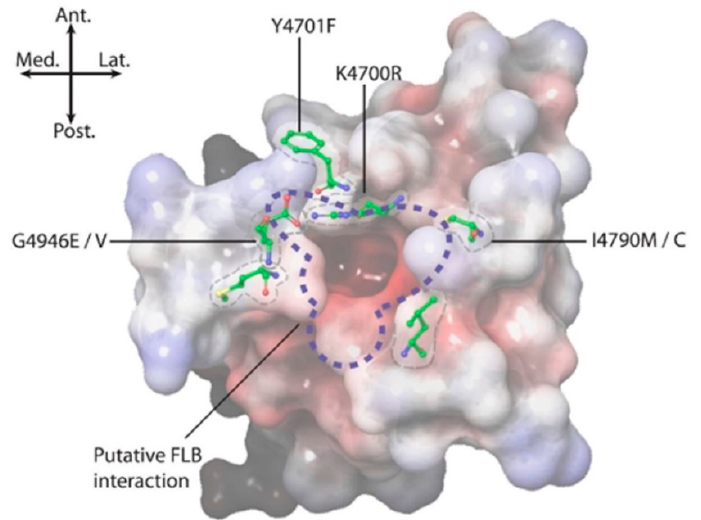
Figure 8. Positional summary of key amino acid residues implicated in diamide binding and insecticide resistance. Electrostatic potential: positive (blue), neutral (white) and negative (red).